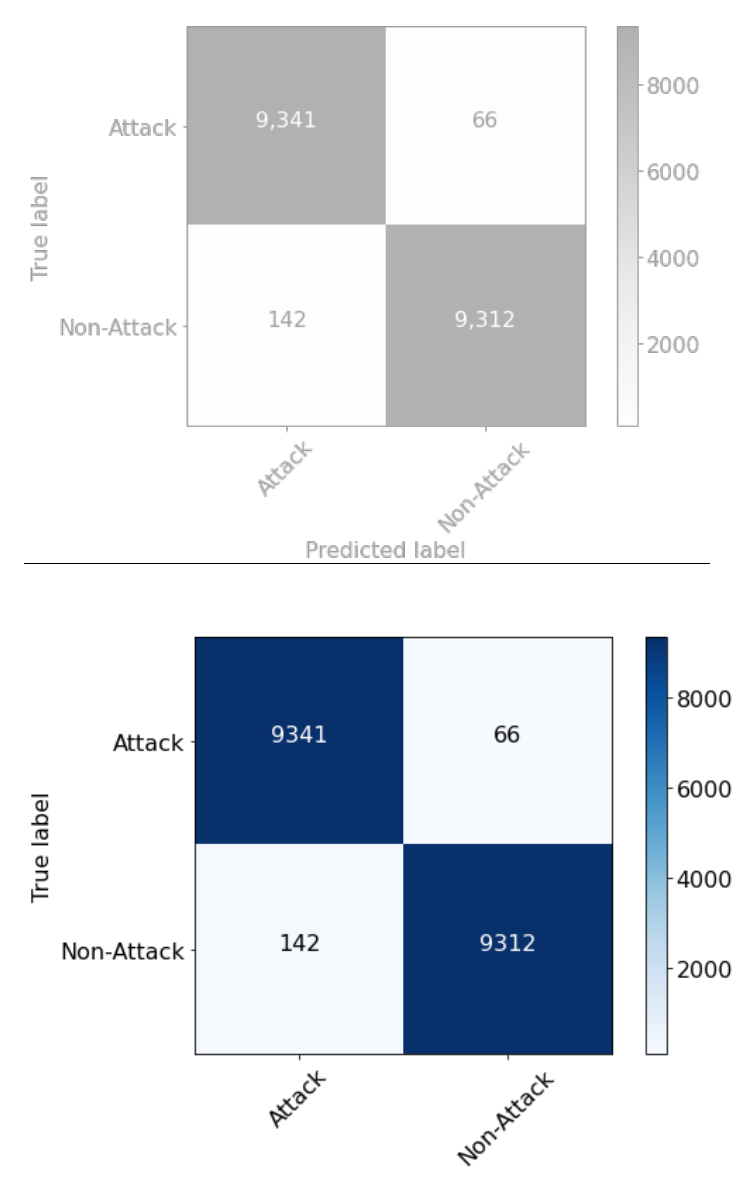
Figure 2. Confusion matrix for XGBoost.